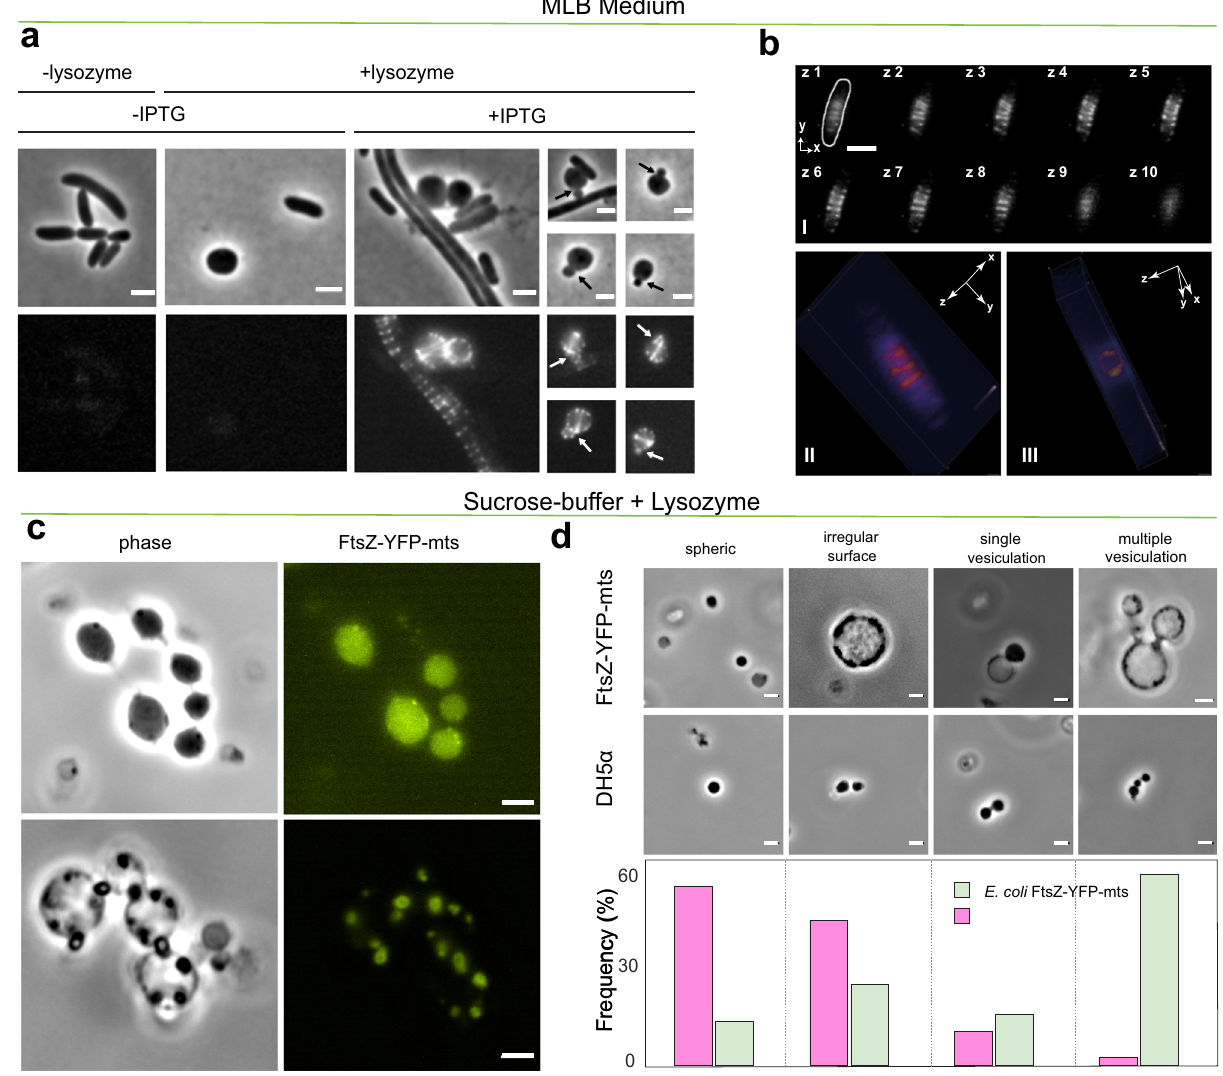
Fig. 6 In wall-less E. coli cells, FtsZ-YFP-mts rings exert outward forces causing budding, vesiculation, and constriction necks. a E. coli DH5 α cells expressing FtsZ-YFP-mts show impaired division and a regular fl uorescence pattern. Removal of the cell wall by lysozyme treatment leads to spheroplast formation. Occasional membrane vesiculation can be correlated to the localization of FtsZ-YFP-mts (arrows) (scale bar = 2 µ m). b Upon induction, cells express FtsZ-YFP-mts polymeric structures perpendicular to the cell length, around midcell (bI). 3D rendering reveals ring-like structures (bII – bIII) (scale bar = 2 µ m). c Attempts to enhance the spheroplasting ef fi ciency (sucrose-buffer) resulted in the emergence of multi vesiculated structures. Points of membrane constriction correlate with presence of FtsZ-YFP-mts. Deformations of the plasma membrane indicate a force generation by FtsZ assemblies that leads to local membrane invaginations and eventually pinching off of vesicles (scale bar = 2 µ m). d Quantitative morphological classi fi cation of induced E. coli DH5 α pEKEx2-ftsZ-yfp-mts cells ( N = 50 cells) compared to E. coli DH5 α ( N = 43 cells), after lysozyme treatment in sucrose-buffer, within the four categories: spheric, irregular surface, single and multiple vesiculation. (Scale bar = 2 µ by immersion in a 50:50 water/ethanol solution followed by 1-min air-plasma acids was obtained by inverse polymerase chain reaction (PCR) using primers cleaning. After this, coverslips were glued to the spacers and passivated for more sZipAI and ZipAII. After PCR puri fi cation, the product was digested with DpnI, than 2h using 5-mg/ml b-casein (Sigma, Germany). Samples are examined for 1h and ligated with T4 DNA ligase. Overexpression of sZipA was induced with IPTG with a consistent evaporation osmolarity ~50 mOsm per hour under constant for 3 h at 37 °C in transformed BL21 cells carrying the pET-15ZIP cloning vector. humidity and temperature conditions. Examined vesicles were located in the After cell lysis and centrifugation, the soluble fraction was loaded on a 5-mL Ni- central area of the chamber, fairly distant from the evaporation meniscus. NTA resin column (Novagen) and the protein was eluted in buffer containing imidazole. Protein purity was con fi rmed by SDS-PAGE and mass spectrometry. Wild-type FtsZ and sZipA were covalently labeled in the amino groups with Alexa Fluor 488 carboxylic acid succinimidyl ester dye (Molecular Probes/ Confocal spinning disk imaging and optical tweezers setup . Confocal spinning Invitrogen) as earlier stated 33 . disk imaging was performed using a Yokogawa CSU10-X1 spinning disk system connected to a Nikon Eclipse Ti inverted microscope (Nikon, Japan). A DPSS laser stack with 488, 561, and 640-nm laser lines (3i, Denver, Colorado USA) is used for Imaging chamber for slow evaporation . The imaging chamber (Fig. S4A) was illumination and an Andor Ixon Ultra 512× 512 EMCCD camera for fl uorescence detection. 3i-Slidebook software controlled lasers, fi lter selection, microscope, xy made using — customized size — coverslip glasses (Menzel, Germany) and a PMMA stage, and acquisition (3i, Denver, Colorado USA). For simultaneous FtsZ-YFP-mts 3-mm height spacer (Fig. 1). The bottom coverslip has 1.5 thickness and 12-mm and ATTO655-DOPE excitation, 488 and 640-nm lasers were rapidly switched by width. The upper one was 1.0 thickness and 10-mm width. Glued coverslips to the an AOTF. For image detection, the use of an appropriated quad-band fi lter avoided spacer form a two-side-open chamber of ~380-µl volume. Coverslips were cleaned